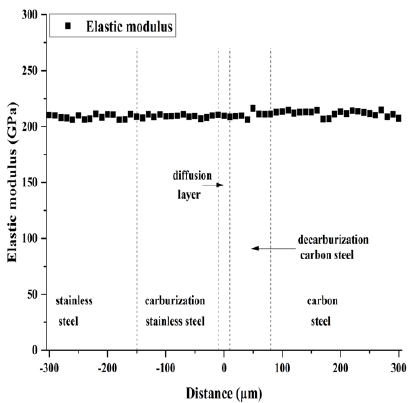
Figure 4. The elastic modulus distribution of stainless steel clad plate.